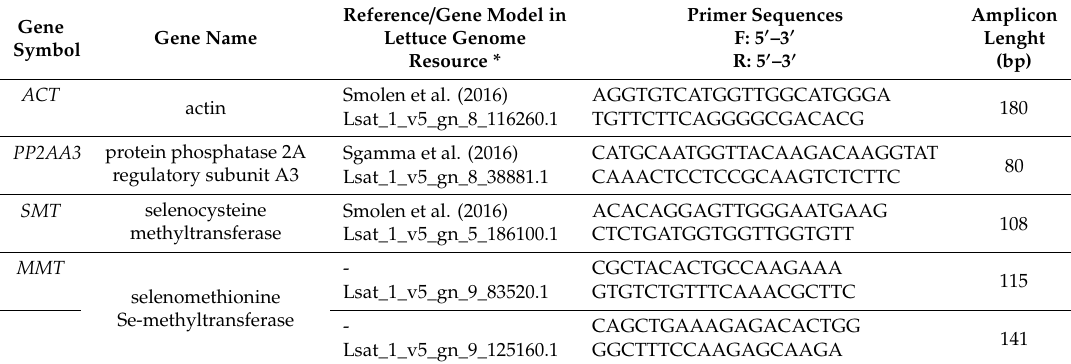
Table 1. Sequences of genes and primers used in the